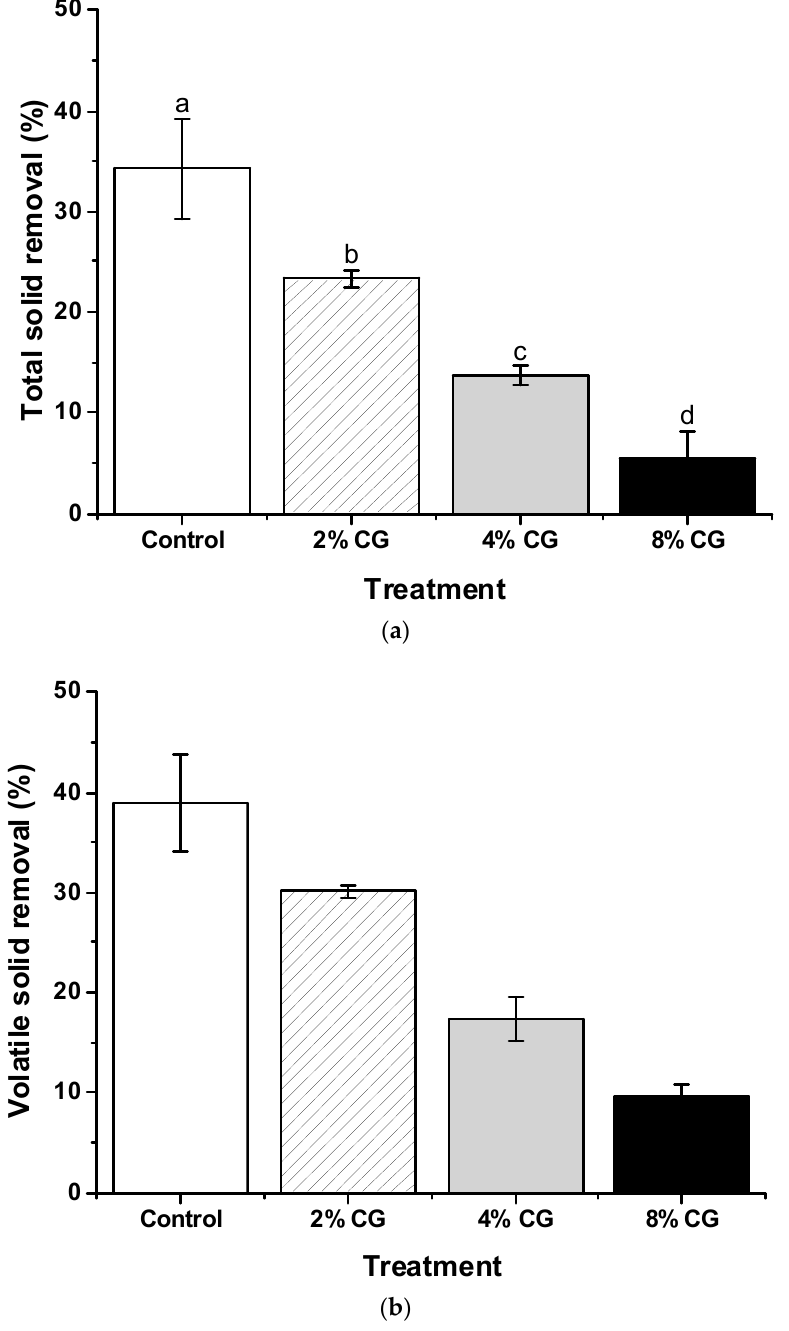
Figure 7. Changes of total solids (TS) ( a ) and volatile solids (VS) ( b ) without or with different percentage of crude glycerol addition.